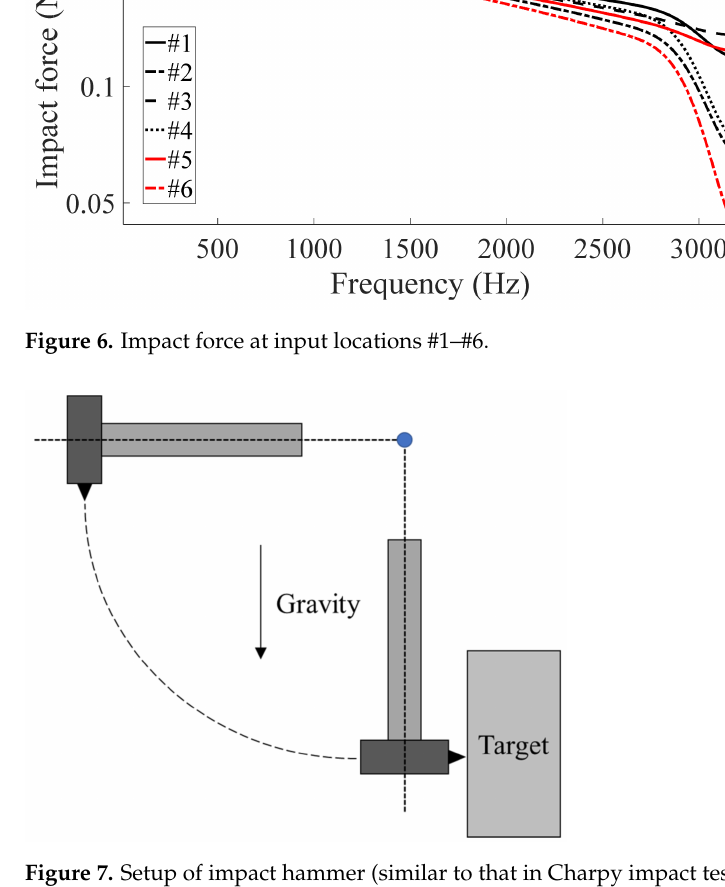
Figure 7. Setup of impact hammer (similar to that in Charpy impact